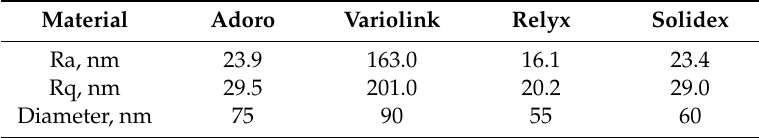
Table 3. Values measured with AFM for the samples exposed to